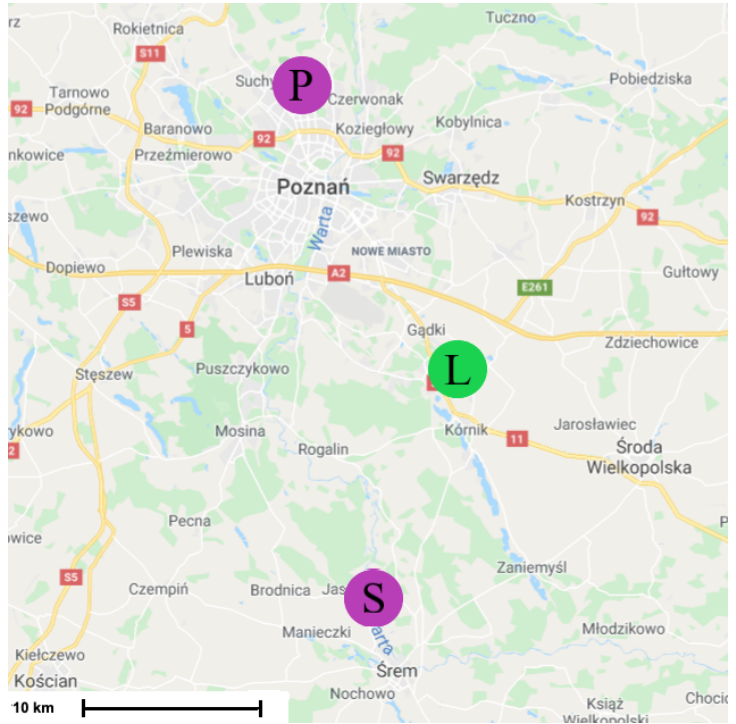
Figure 7. Location of LOFAR station in Borowiec (L) and transmitters in Srem (S) and Piatkowo (P).